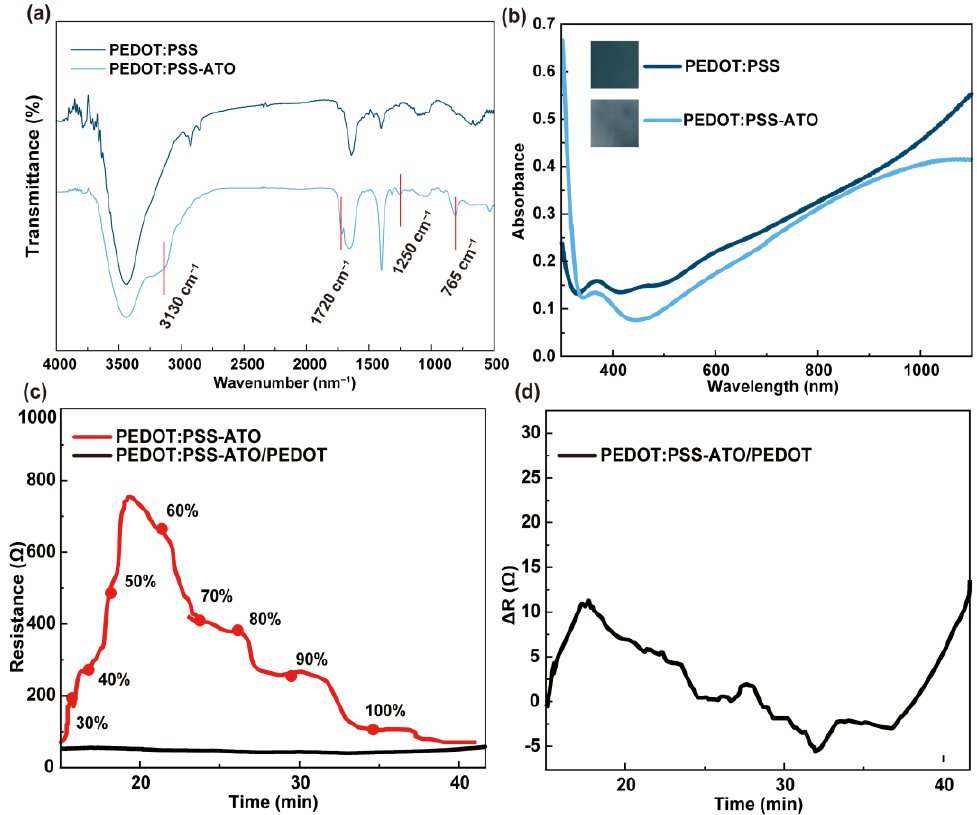
Figure 2. ( a ) Fourier transform spectra of PEDOT:PSS and PEDOT:PSS-ATO films. ( b ) UV-visible absorption spectra of PEDOT:PSS and PEDOT:PSS-ATO films (inset: photos of the film). Resistance– time curves of ( c ) PEDOT:PSS-ATO and PEDOT:PSS-ATO/PEDOT films under increasing levels of chamber humidity (30–100% RH). ( d ) ΔR of PEDOT:PSS-ATO/PEDOT film under increasing levels of chamber humidity (30–100% RH).